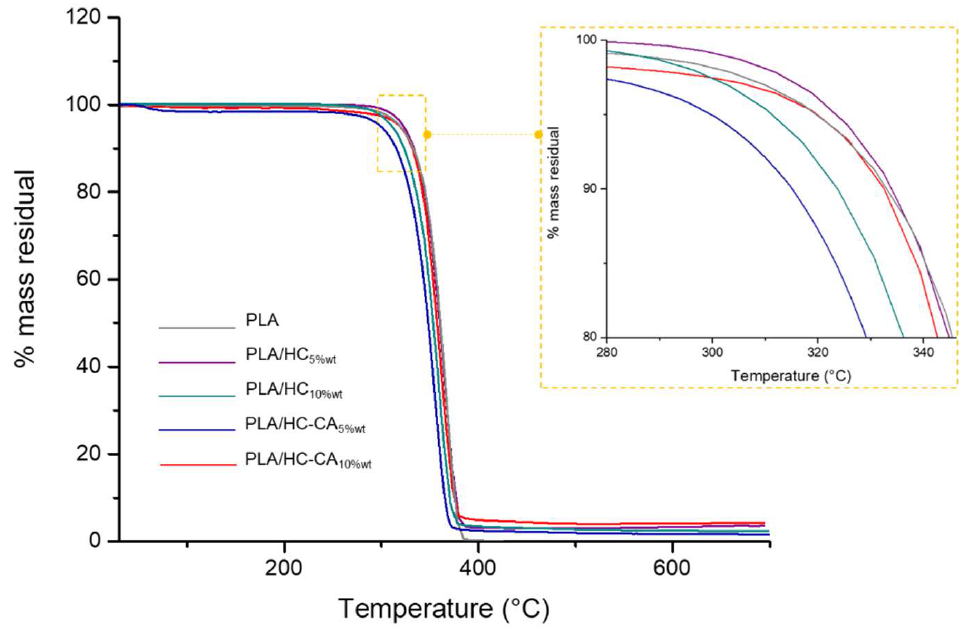
12 of 16 Figure 10. Representative XRD patterns of PLA-based biocomposite films (PLA + hemp cellulose; PLA + functionalized hemp cellulose), compared to neat PLA. Spectra were processed using OriginPro 2015 software.